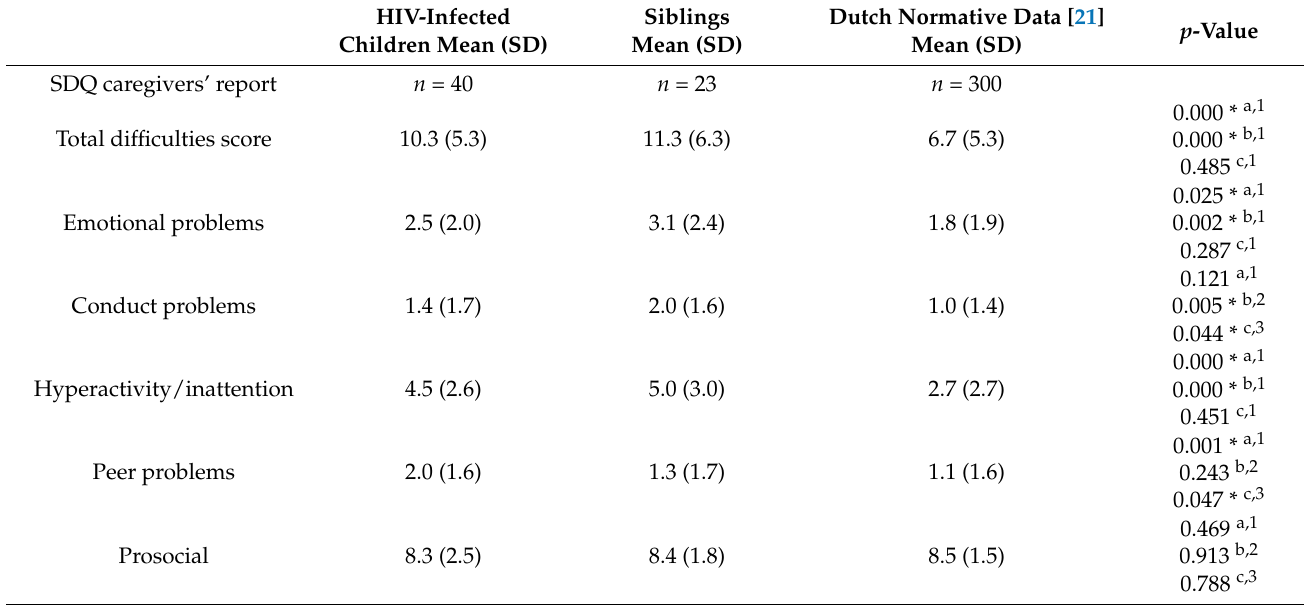
Table 4. Results SDQ caregivers’